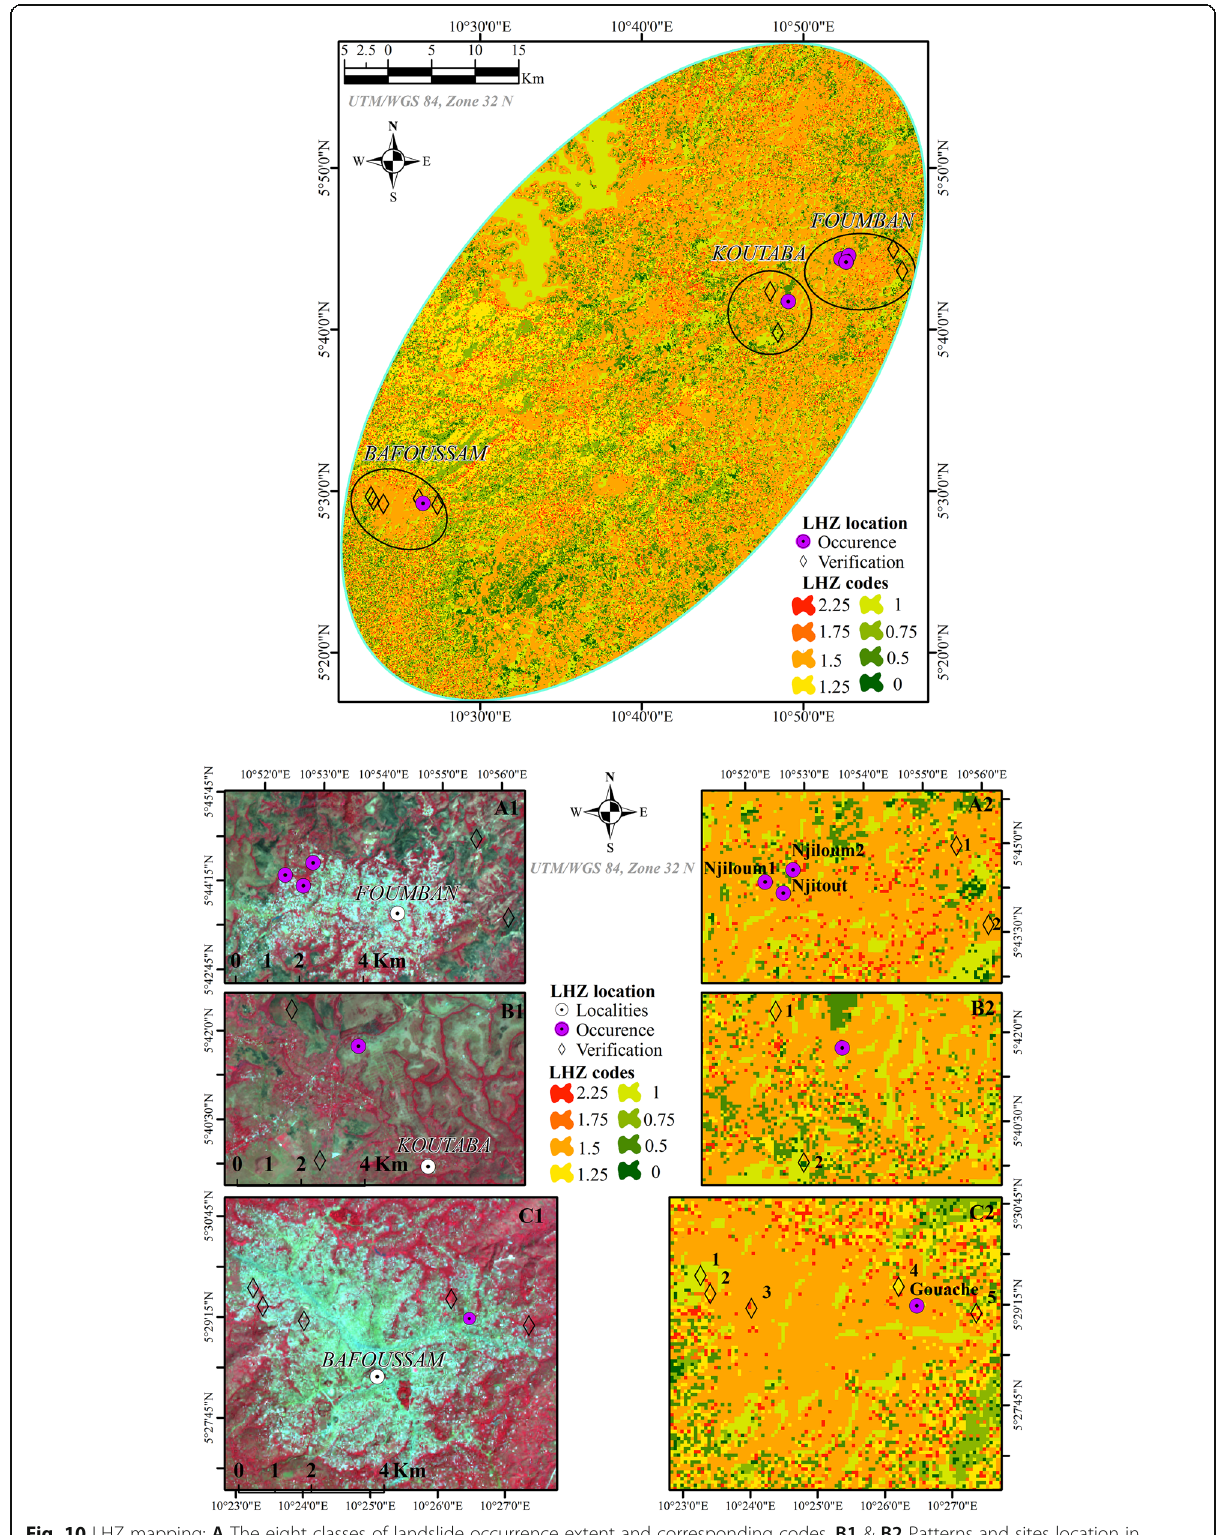
Fig. 10 LHZ mapping: A The eight classes of landslide occurrence extent and corresponding codes, B1 & B2 Patterns and sites location in Foumban, C1 & C2 Patterns and sites location in Koutaba, D1 & D2 Patterns and sites location in